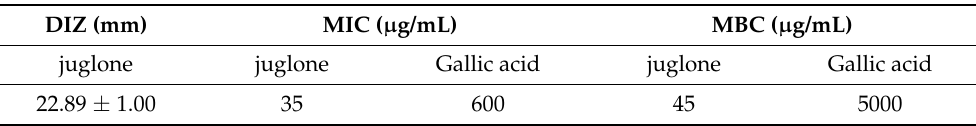
Figure 2. ( A ) Chemical structure formula of juglone; ( B ) growth curve of P. aeruginosa exposed to juglone.